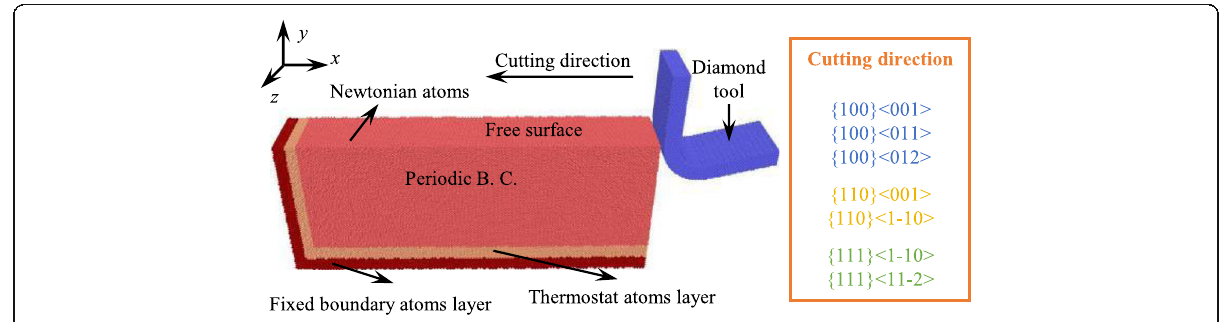
Fig. 1 Schematic description of